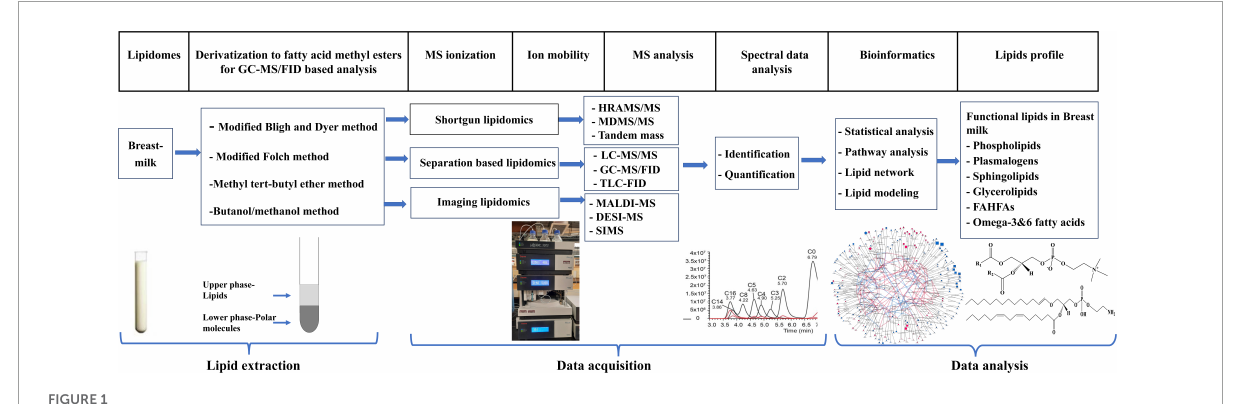
FIGURE1 Typical workflow of lipidomic analysis of breast milk sample.